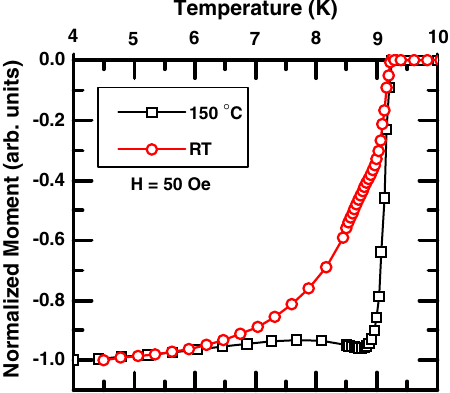
FIG. 5. (a) RHEED pattern for Nb(110)/Cu(100)/Si(100) along the Si[100] and Si[110] azimuths. (b) A representative 2 (cid:3) m (cid:4) 2 (cid:3) m AFM scan for Nb films on the Cu lower root mean square (RMS) roughness (1.98 nm for RT, 2.87 nm for 150 (cid:2) C ).